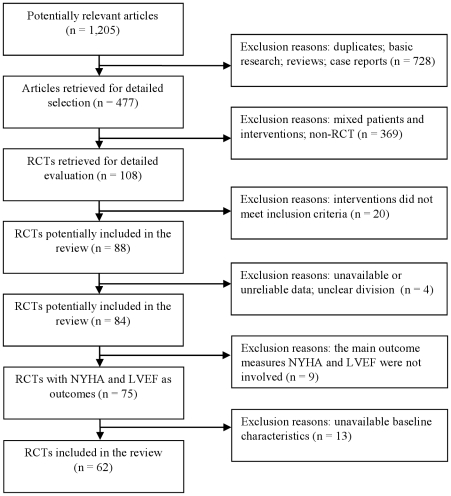
Flow diagram of the article selection for this study.